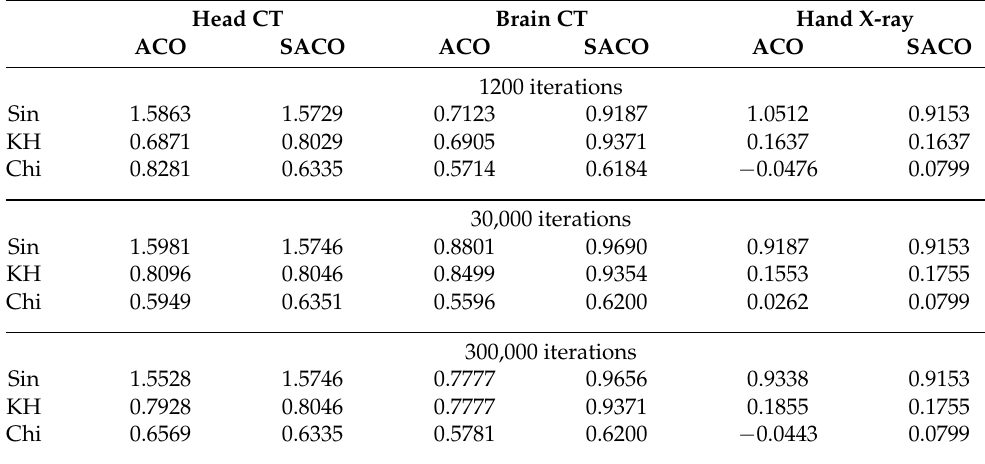
Table 3. The best number of correctly identified number of pixels, standardized using the overall average and standard deviation for all considered medical images, with every considered operator on all considered algorithms; results for sensitive (SACO) and original ACO methods. Head CT Brain CT Hand X-ray ACO SACO ACO SACO ACO SACO 1200 iterations Sin